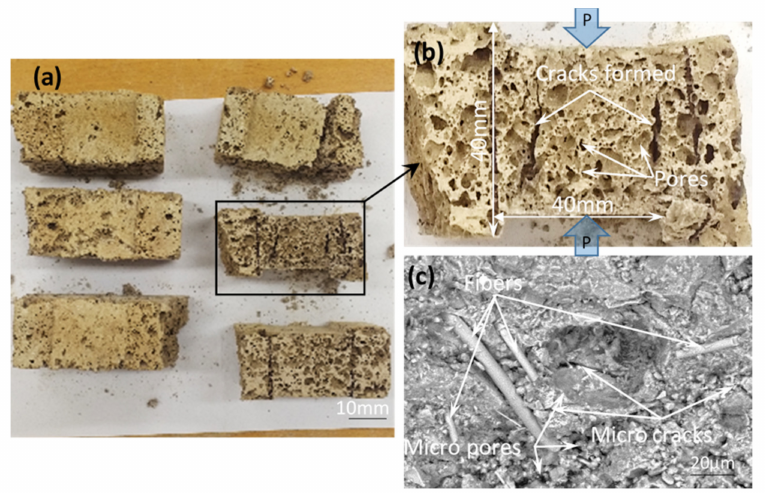
Figure 6. Failure modes of GF specimens: ( a ) the compression test of the broken parts, ( b ) surface failure of samples, and ( c ) micrograph of